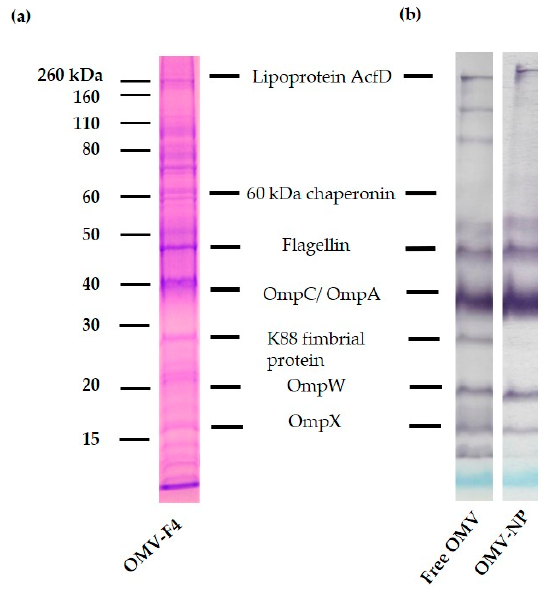
Figure 1. Protein profile and antigenicity of the outer membrane vesicle (OMV) encapsulated into nanoparticles. SDS-PAGE with Coomassie blue staining of OMV from F4 Escherichia coli ( a ). Molecular weight markers are indicated on the left in kDa. Immunoblotting using sera from infected piglets with F4 E. coli , showing the main antigenic proteins from OMV ( b